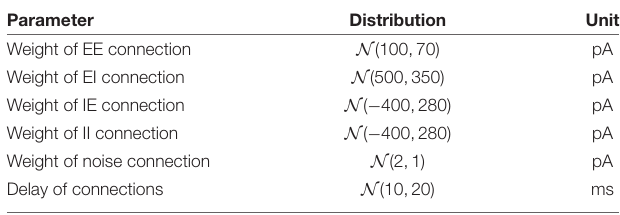
TABLE 2 | Parameters of network